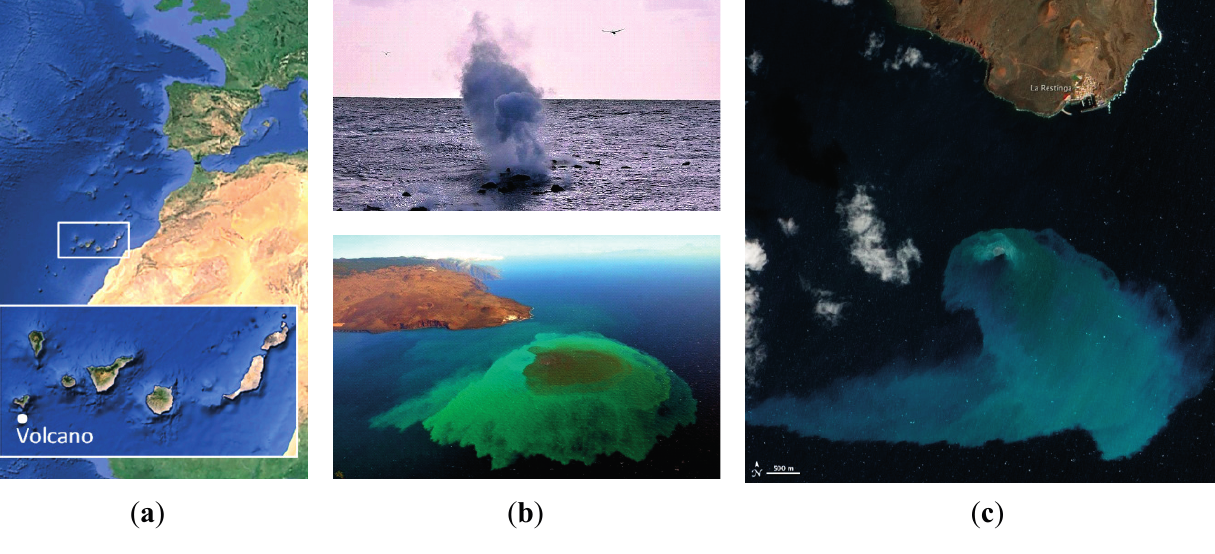
Figure 1. Submarine volcano eruption at El Hierro Island during October 2011: ( a ) location of the underwater volcano; ( b ) photographs during the eruption; and ( c ) satellite image by NASA EO-1 ALI ©